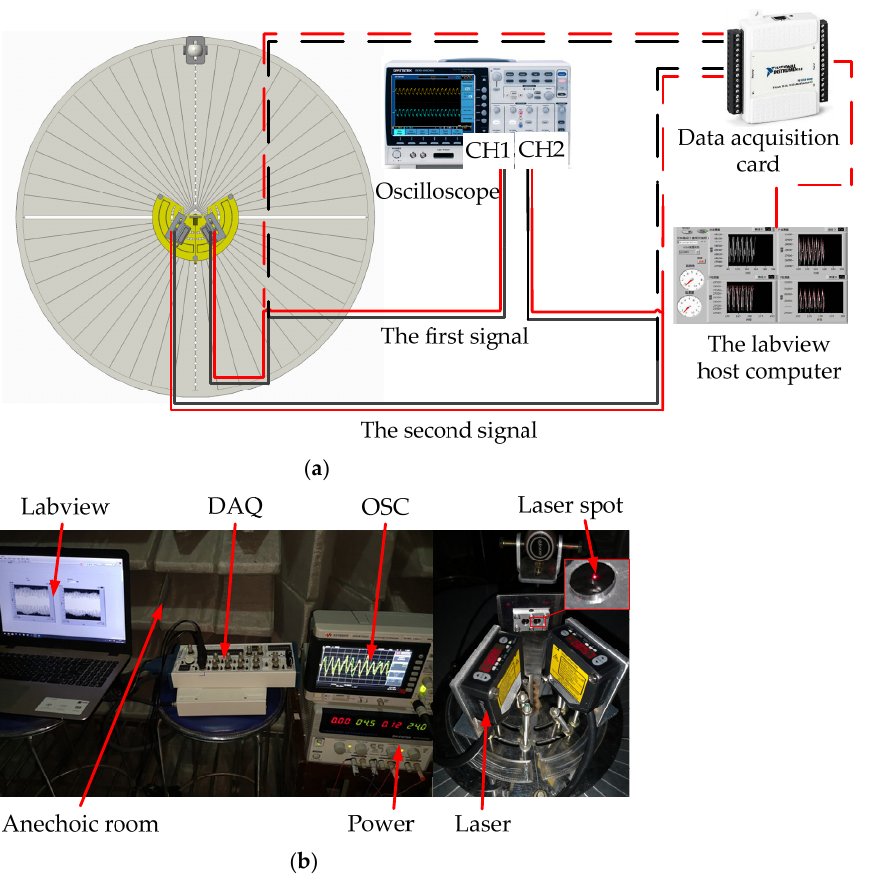
Figure 15. The signal acquisition process of the test experimental. ( a ) The signal acquisition scheme of the test experiment. ( b ) The experimental photos.